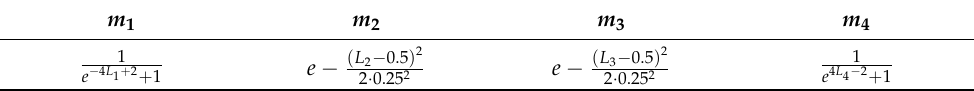
Table 1. Weight formulas for RBF light enhancement fusion algorithm.